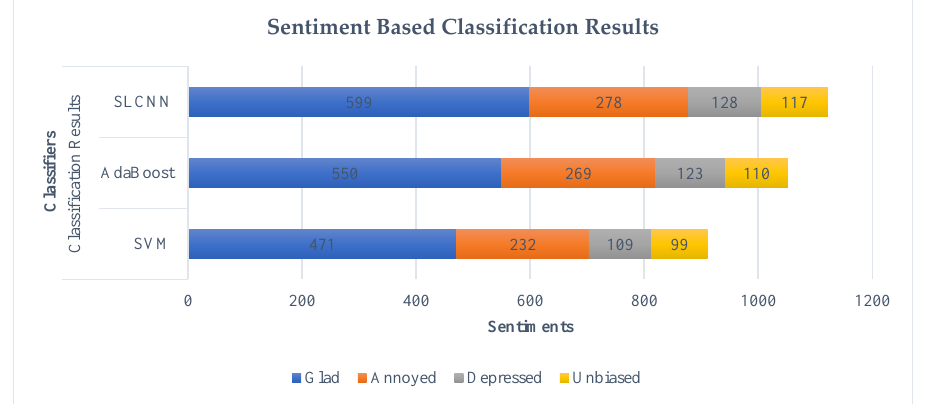
Figure 8. Text-Based Sentimental Classification.